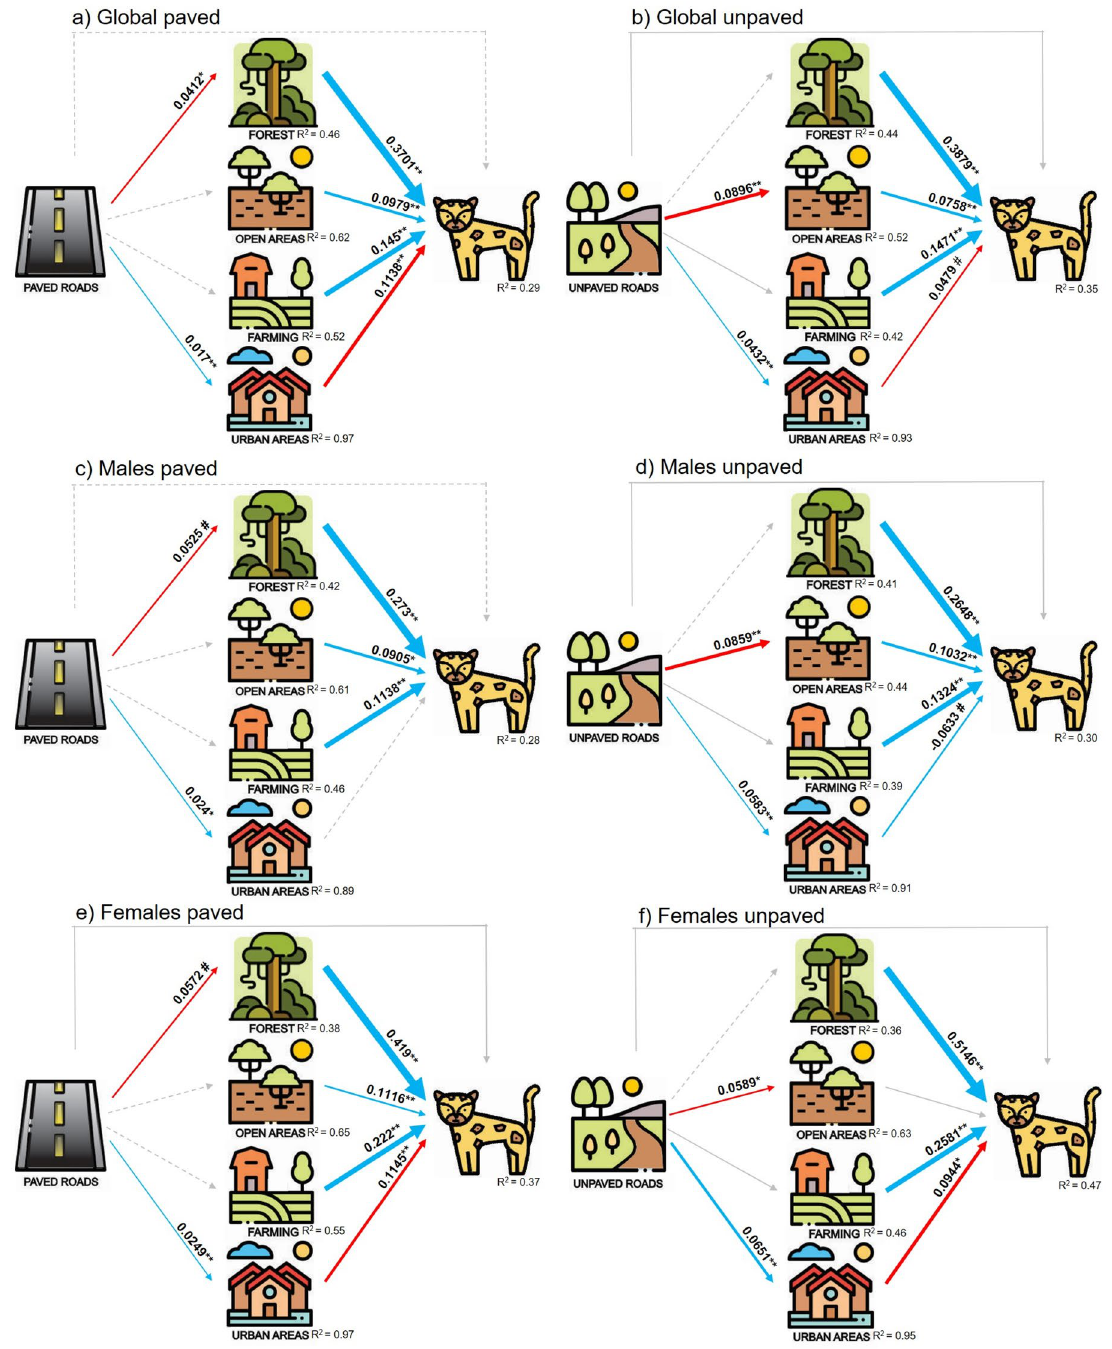
Figure 3. Path diagrams representing the effects of roads and land cover on jaguars’ space use for the global model ( a , b ), for males ( c , d ), and females ( e , f ) for paved and unpaved roads, respectively. Arrows represent unidirectional relationships among variables. Colored arrows indicate positive (blue) and negative (red) significant effects and gray arrows denote non-significant positive (solid) or negative (dashed) paths. The numbers associated with the arrows provide the standardized coefficients and the width of the arrows refers to the size of the coefficients of significant effects. Numbers below the response variables are pseudo- R -squared values. Note that for those variables measured as distances (roads and urban areas), a negative effect occurred when the coefficient is positive, and vice-versa, except for the effect of roads on urban areas which are both measured as distances (Supplementary Table S2 online). # marginally significant effect with p- value < 0.1, * p -value < 0.05, and ** p -value <